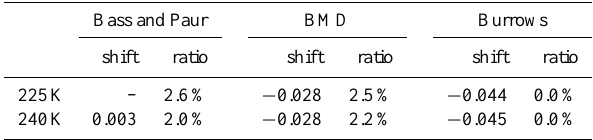
Table 6. Direct comparison of GOME-2 FM3 with respect to liter- ature data using a nonlinear least square fitting programme in the DOAS fitting window (326.6–334.5nm).